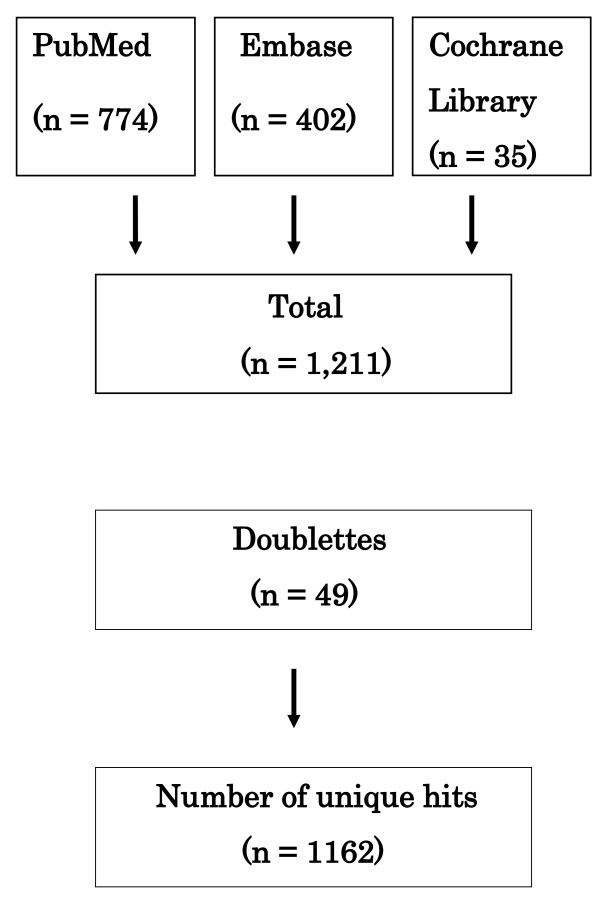
Number of hits in the various databases.